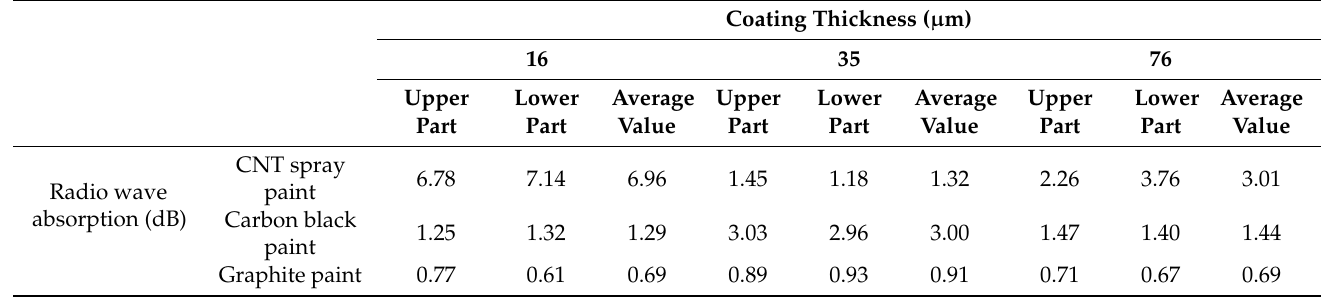
Table 2. Radio wave absorption in the 75 GHz band.